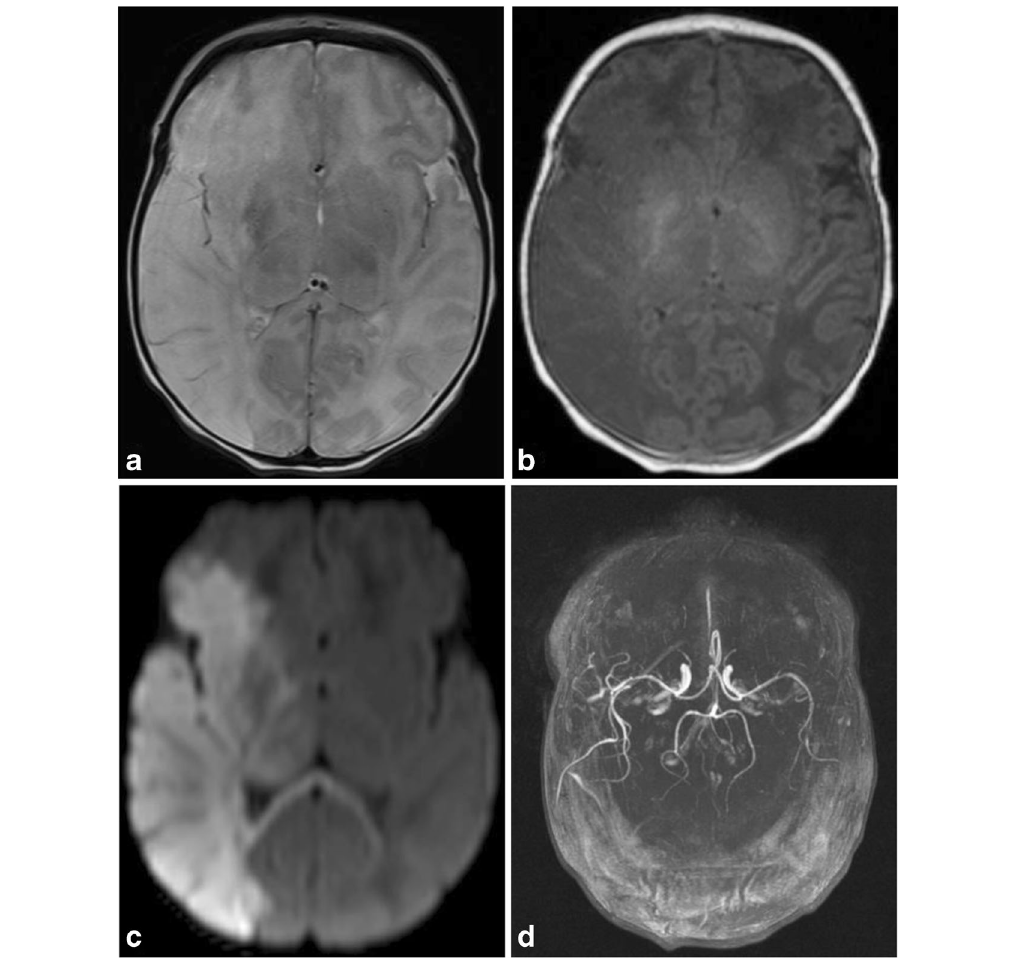
Fig. 12 Spinal cord injury in 4-day-old female with a history of shoulder dystociapresenting with rightsided upper and lower extremityneurologic deficits Axial T2 (a) and sagittal T1 (b) images of the cervical spine demonstrate a focal area of T1 hyperintensity and T2 hypointensity